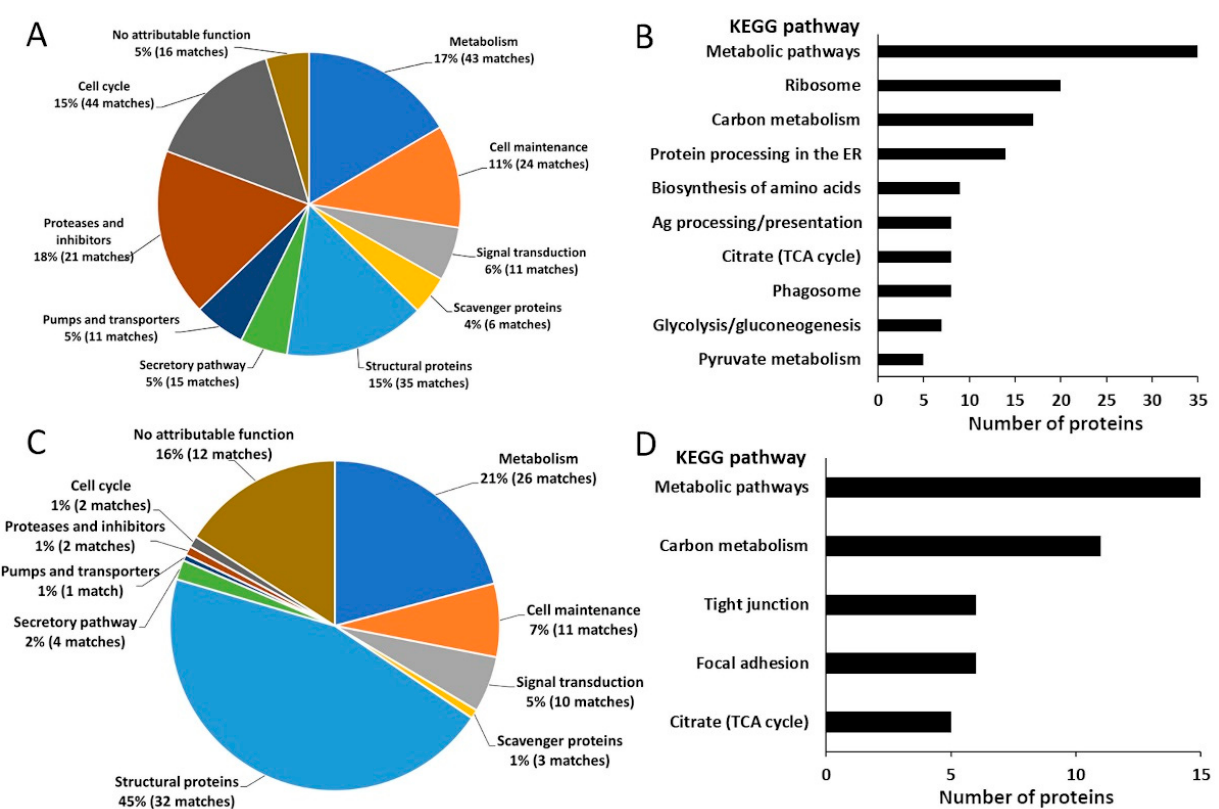
Figure 1. Different functional groups of proteins identified in the laser microdissected gut and tegument. ( A ) The percentage distribution of F. hepatica gastrodermal cell proteins within different functional groups based on their relative abundance. The number of matches corresponds to the number of different proteins that were detected in each category. ( B ) The number of proteins in gastrodermal cells associated with KEGG pathways. ( C ) The percentage distribution of F. hepatica laser microdissected tegument proteins within different functional groups based on their relative abundance. ( D ) The number of proteins in the LMD tegument associated with KEGG pathways.